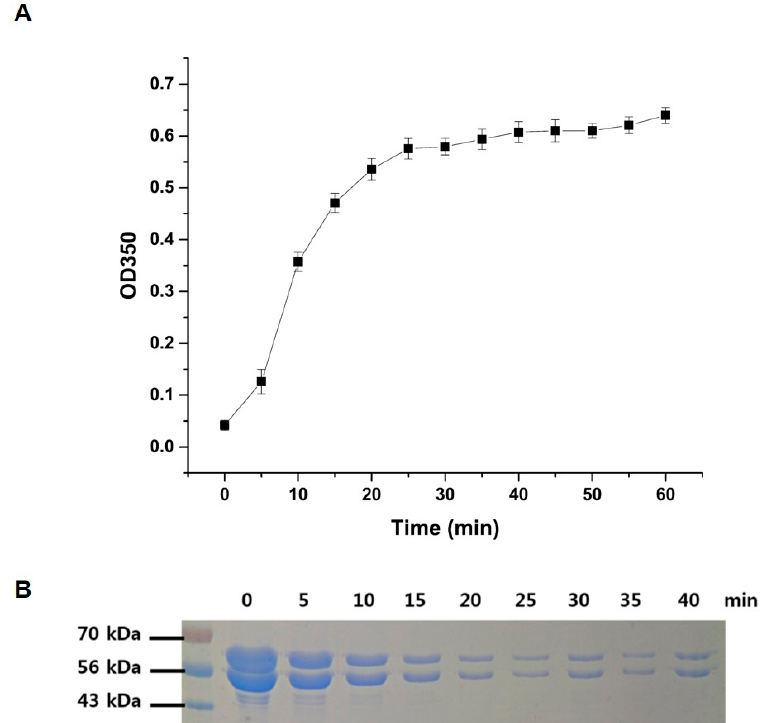
Figure 2. Polymerization of P. capsici α , β -tubulin. ( A ) The rate of the polymerization reaction was monitored by light scattering at 350 nm; as the polymerization progresses, the turbidity of reactant increases. ( B ) Time-dependent analysis of polymerization was confirmed by SDS-PAGE analysis. Due to the combining of α , β -tubulin for polymerization, both tubulins are consumed and the band intensity at 55 and 57 kDa decreases over time.